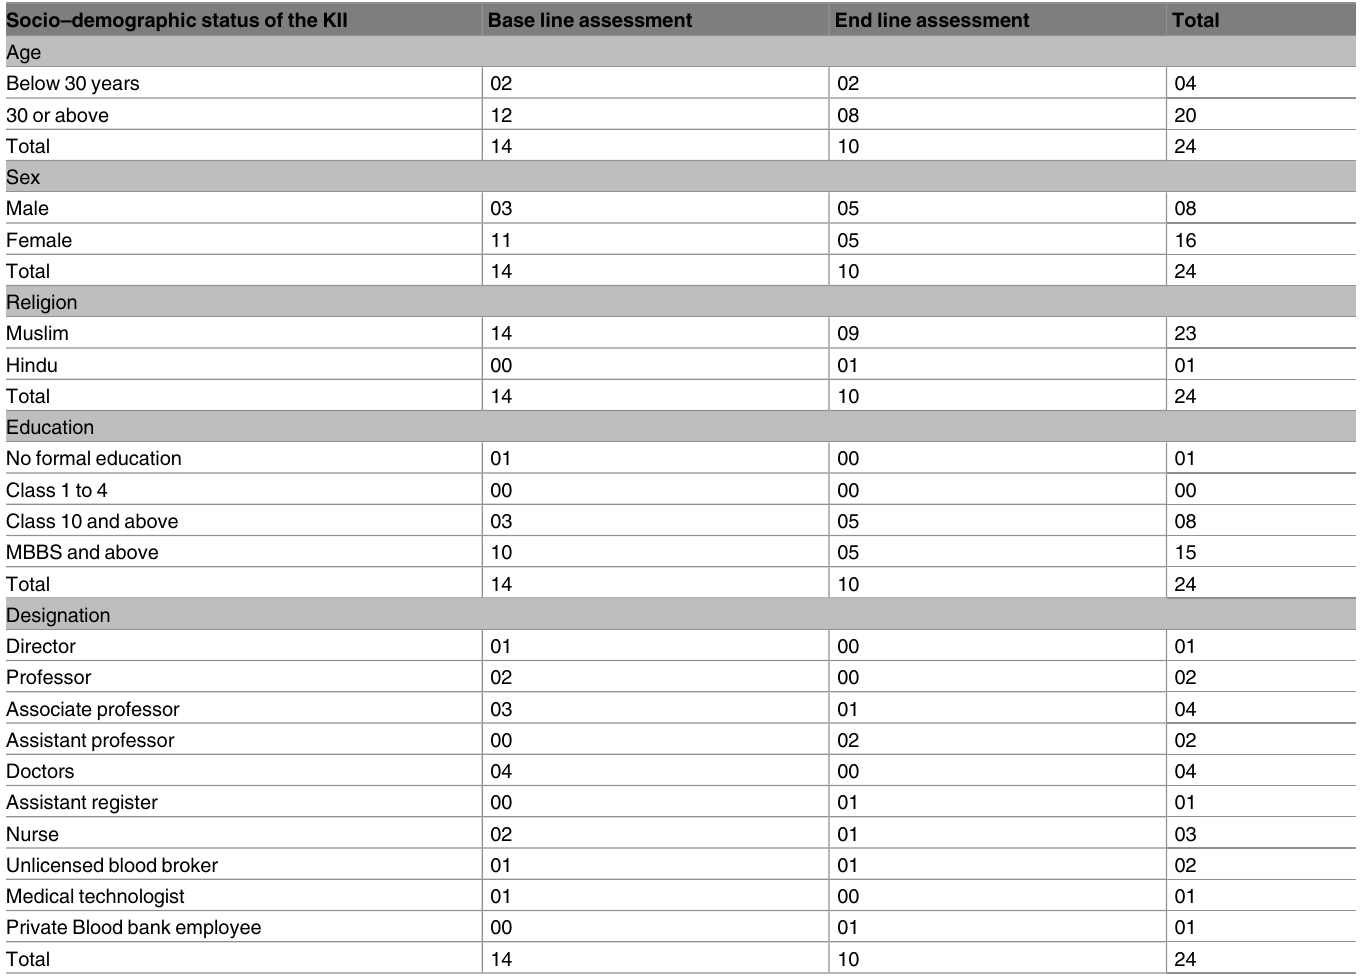
Table 2. Socio demographic information of key